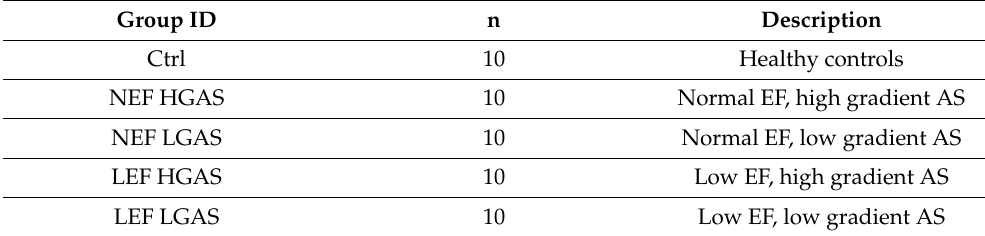
Table 1. Graduation of different subtypes of AS as determined by the ESC guidelines; LVEF was determined as ≤ 50%, HG AS was determined as gradient ≥ 40